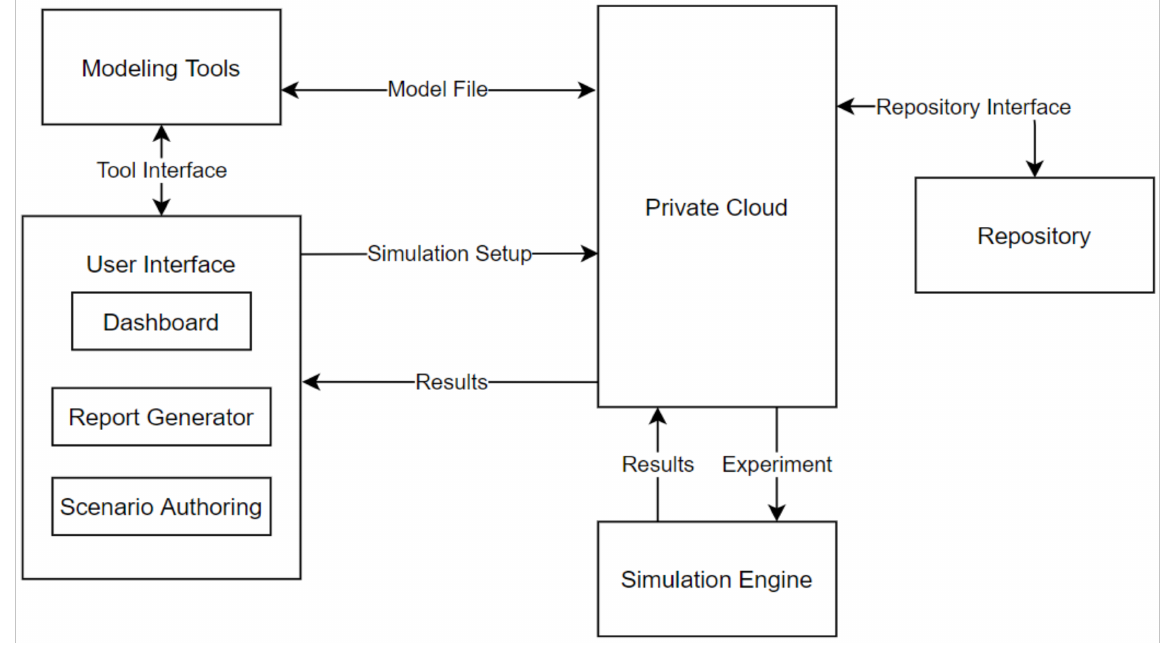
Figure 2. Prototype MBSE testbed logical